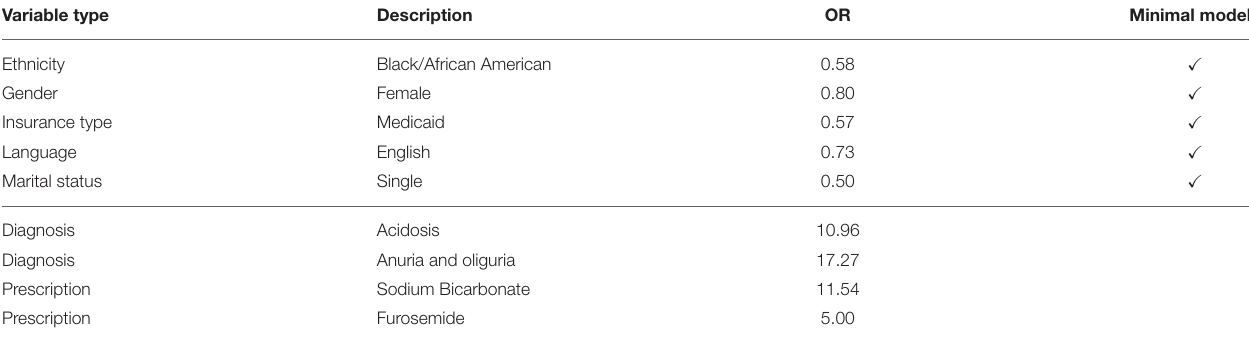
TABLE 3 | A list of rules that apply to a fictional